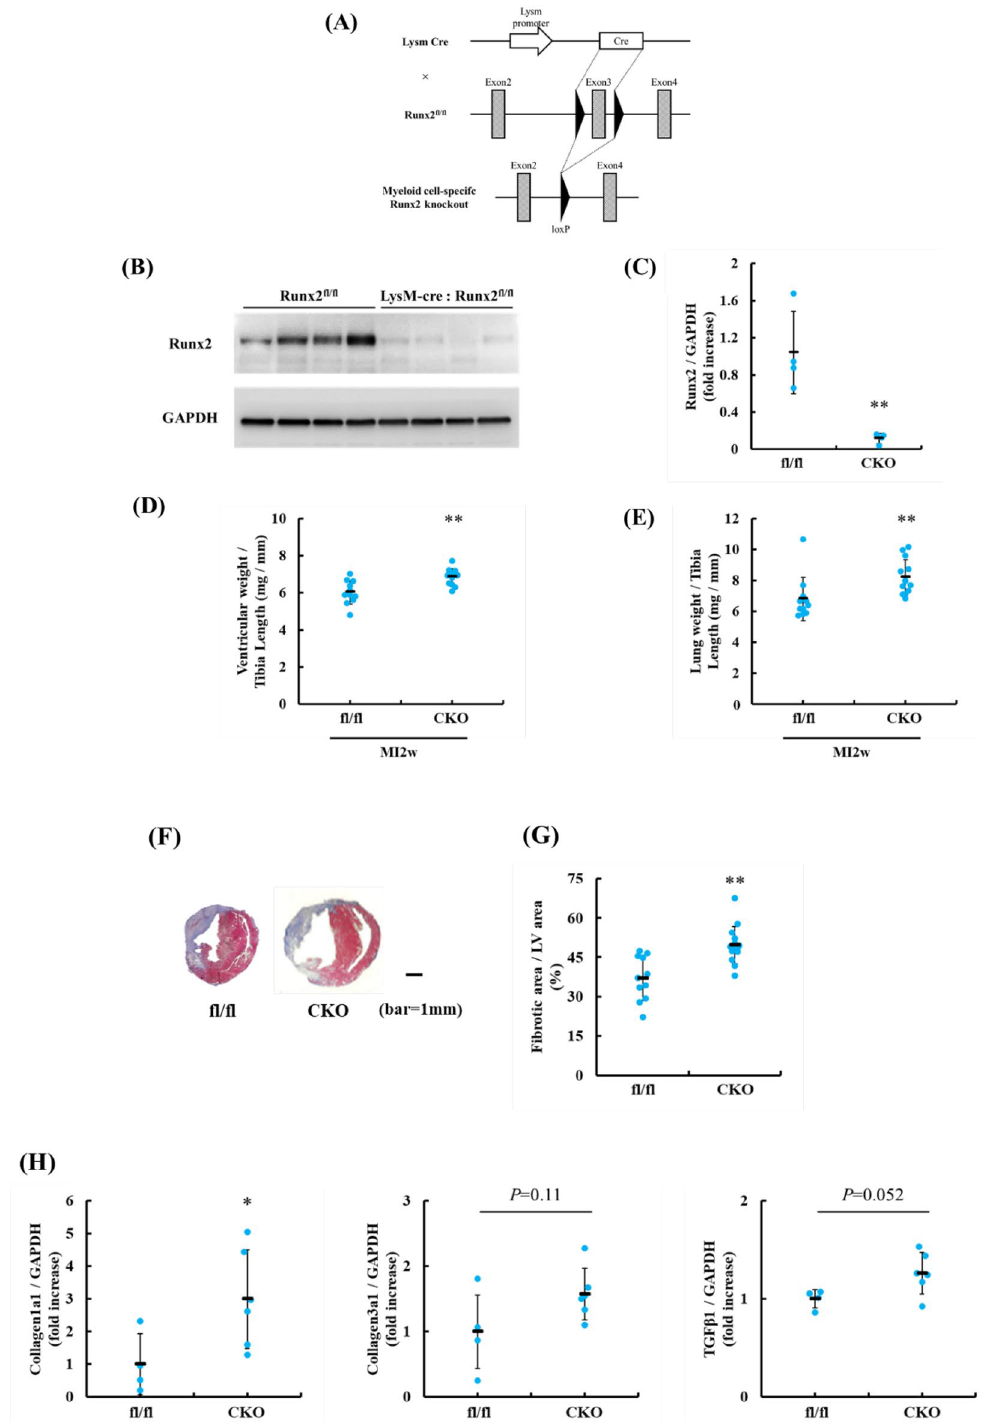
Figure 3. Myeloid cell-specific Runx2 ablation deteriorated adverse cardiac remodeling after MI. ( A ) Simplified scheme using Cre-loxP system is shown to generate myeloid cell-specific Runx2-deficient mice. ( B , C ) Seven days after MI, the sorted CD11b + F4/80 + cells lysates from Runx2 fl/fl , a control, and Runx2 CKO mice were immunoblotted with anti-Runx2 and anti-GAPDH antibodies. ( B ) Representative images are shown. ( C ) Runx2 expression was quantified. Data are shown mean ± SD (n = 4), ** P < 0.01 vs Runx2 fl/fl by Welch’s t -test. ( D , E ) Ratios of ventricular weight to tibia length ( D ) and lung weight to tibia length ( E ) were calculated 14 days after MI. Data were shown as mean ± SD (n = 11 for Runx2 fl/fl mice, n = 13 for Runx2 CKO mice), * P < 0.05, ** P < 0.01 vs Runx2 fl/fl by Mann Whitney’s U test. ( F , G ) Heart sections were prepared from Runx2 fl/fl and Runx2 CKO mice 14 days after MI and stained with Masson’s trichrome method. ( F ) Representative images are shown. ( G ) The ratio of fibrotic area to LV area was quantitatively estimated. Data are shown as mean ± SD (n = 11 for Runx2 fl/ fl mice, n = 14 for Runx2 CKO mice), ** P < 0.01 vs Runx2 fl/fl by Student’s t -test. ( H ) Quantitative RT-PCR was performed for collagen1a1 , collagen3 , and Tgfβ1 7 days after MI. The results were normalized to that of GAPDH. Data are shown mean ± SD (n = 4 for Runx2 fl/fl mice, n = 6 for Runx2 CKO mice). * P < 0.05 vs Runx2 fl/fl by Mann Whitney’s U